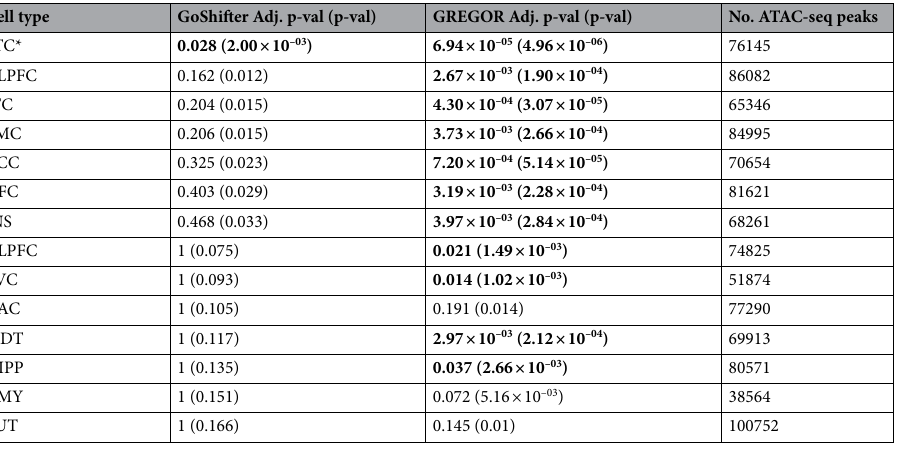
Table 1. Enrichment of PD risk variants within open chromatin regions in neurons from different brain regions. The cell type passing the significance threshold with both GoShifter and GREGOR is marked with a star and is reported in the text as significantly enriched with PD risk variants. We adjusted for multiple testing by Bonferroni correction, adjusting for 14 tests. Unadjusted p-values are provided in parenthesis. Adjusted p-val < 0.05 are written in bold. No. ATAC-seq peaks refers to the total number of peaks, representing open chromatin regions, in the analysed cell types. PD, Parkinson’s disease; ACC, Anterior cingulate cortex; AMY, Amygdala; DLPFC, Dorsolateral prefrontal cortex; HIPP, Hippocampus; INS, Insula; ITC, Inferior temporal cortex; MDT, Mediodorsal thalamus; NAC, Nucleus Accumbens; OFC, Orbitofrontal cortex; PMC, Primary motor cortex; PUT, Putamen; PVC, Primary visual cortex; STC, Superior temporal cortex; VLPFC, Ventrolateral prefrontal